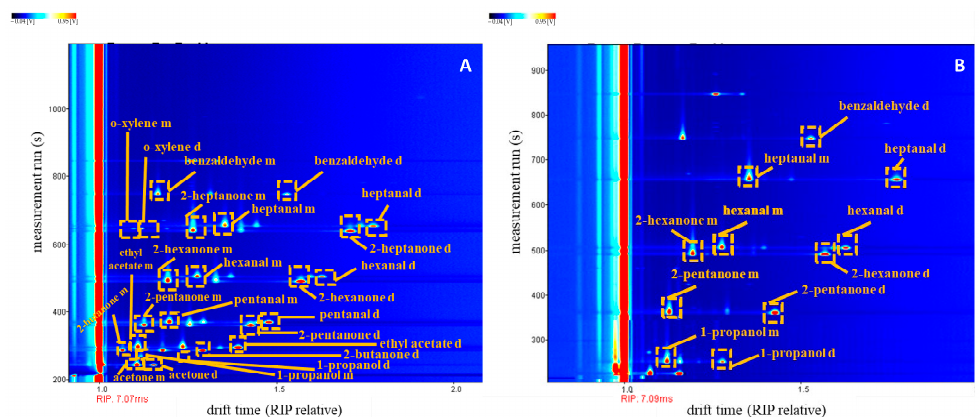
Figure 3. Volatile organic compounds were identified in urine ( A ) and serum ( B ) samples. Table 2. VOCs identified by HS ‐ GC ‐ IMS in urine and serum samples.